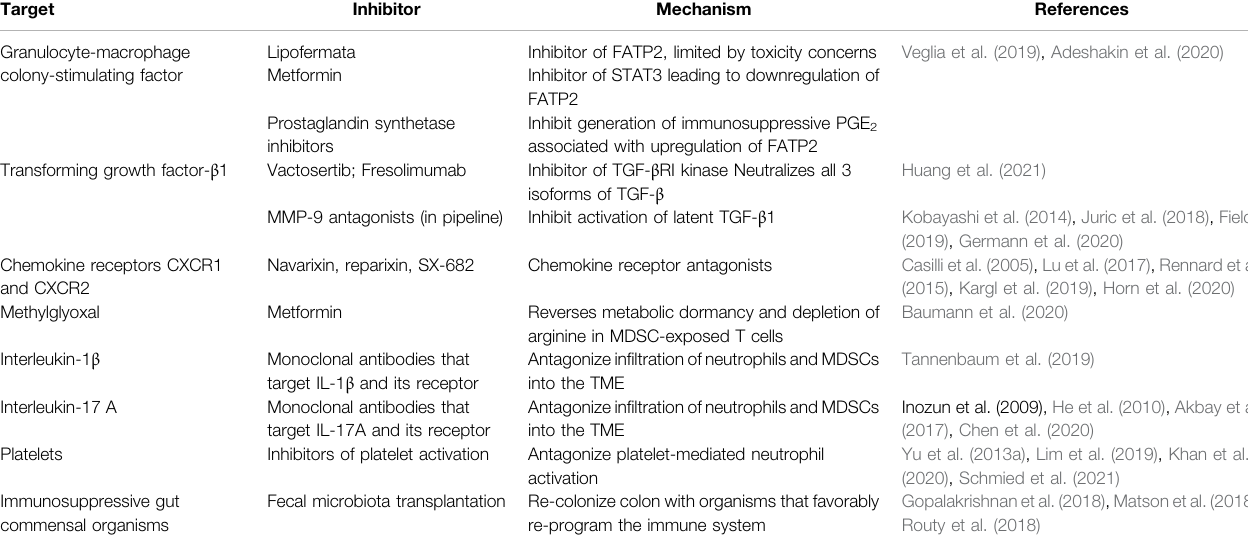
TABLE 1 | Potential targets and pharmacological/biological strategies to attenuate the immunosuppressive, pro-tumorigenic activities of neutrophils and MDSCs.